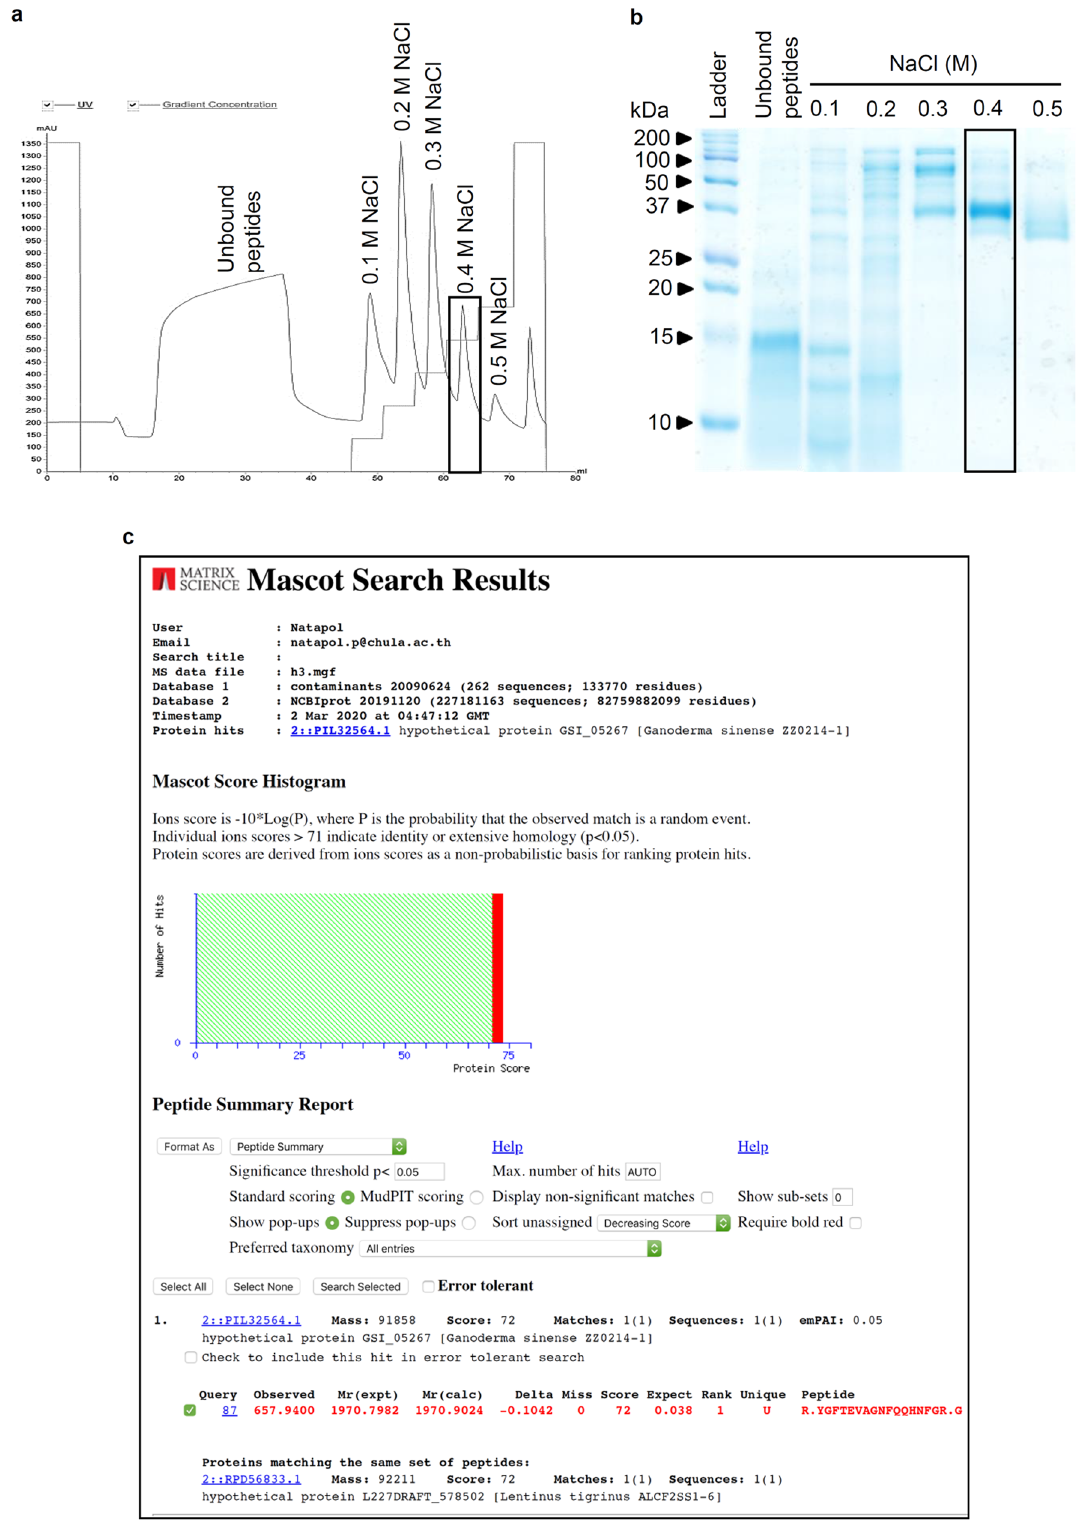
Figure 1. Purified peptide from aqueous extract of Lentinus squarrosulus (Mont.). ( a ) Chromatogram of eluted peptides obtained from FPLC at different concentrations of NaCl. ( b ) Peptide composition of different fractions from L. squarrosulus extracts analyzed by SDS-PAGE. The rectangular box indicates the purest fraction, 0.4 M NaCl peptide. ( c ) The Mascot search web service indicated 72 similarity score of proteomic analysis of 0.4 M NaCl peptide with extracellular metalloproteinase from Ganoderma sinense ZZ0214-1 and Lentinus tigrinus